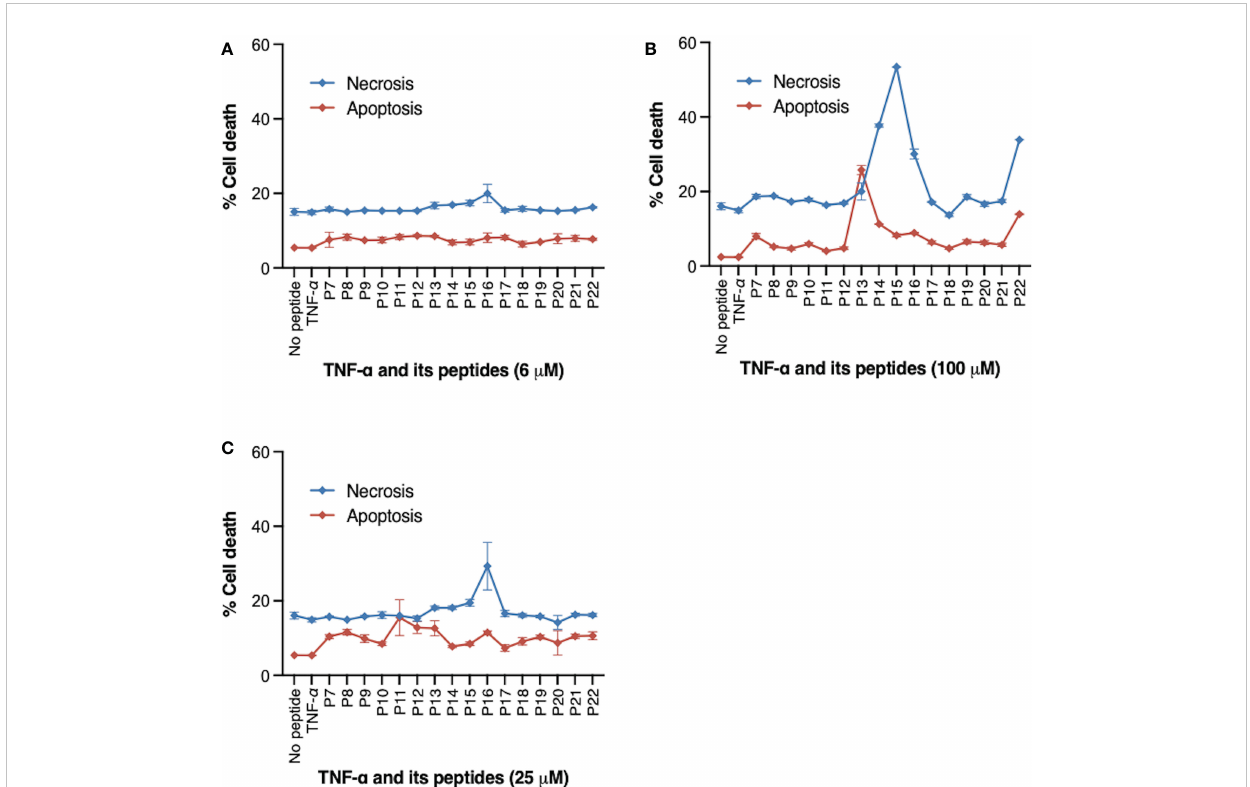
FIGURE 3 Peptides derived from TNF and their effect on cell death. MT2 cells were incubated with TNF protein (20 ng/ml), TNF peptides (P7-P22) at indicated concentrations, or DMSO (no peptide control) for 24 hours. (A) 6 m M (B) 50 m M (C) 100 m M. Frequency (%) of cell death was identi fi ed by Caspase-3 and live-dead dye double staining and measured by fl ow cytometry. P13 peptide at 100 m M induced high frequency of cell apoptosis (indicated by % of Caspase-3+ live-dead- cells). P14, P15, and P16 peptides at 100 m M induced predominantly cell necrosis (indicated by % of Caspase-3- live-dead+ cells). Data are from four independent